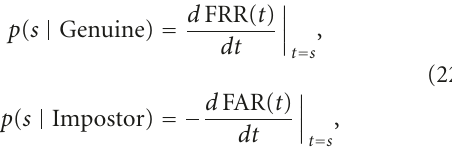
Table 3. The fusion of 3 -feature-based method